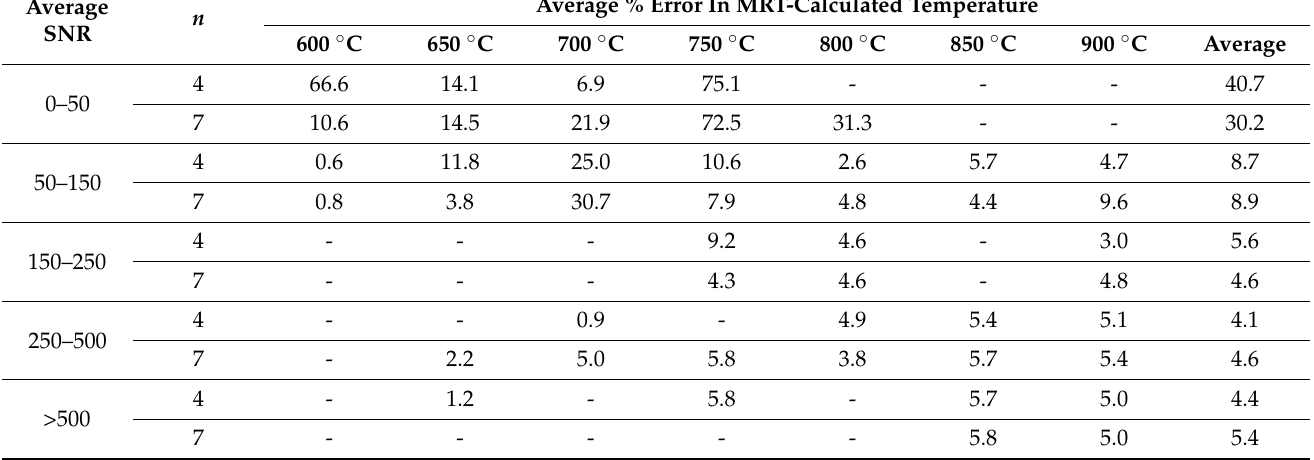
Table 2. Error in MRT-calculated temperature at range of SNR values (W/m 2 - µ m) using four and seven spectral channels ( n = 4 and 7) and the synthetic surface-emission